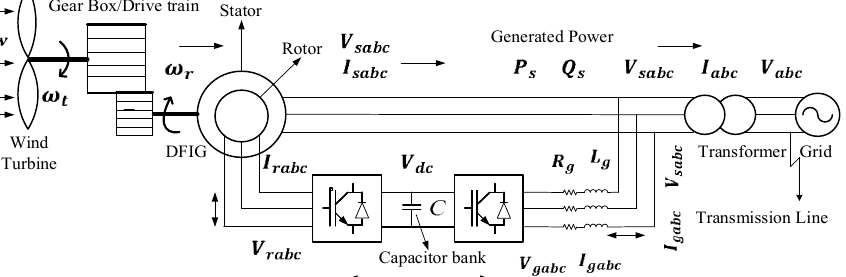
Figure 2. Physical model of DFIG ‐ based wind generation system.